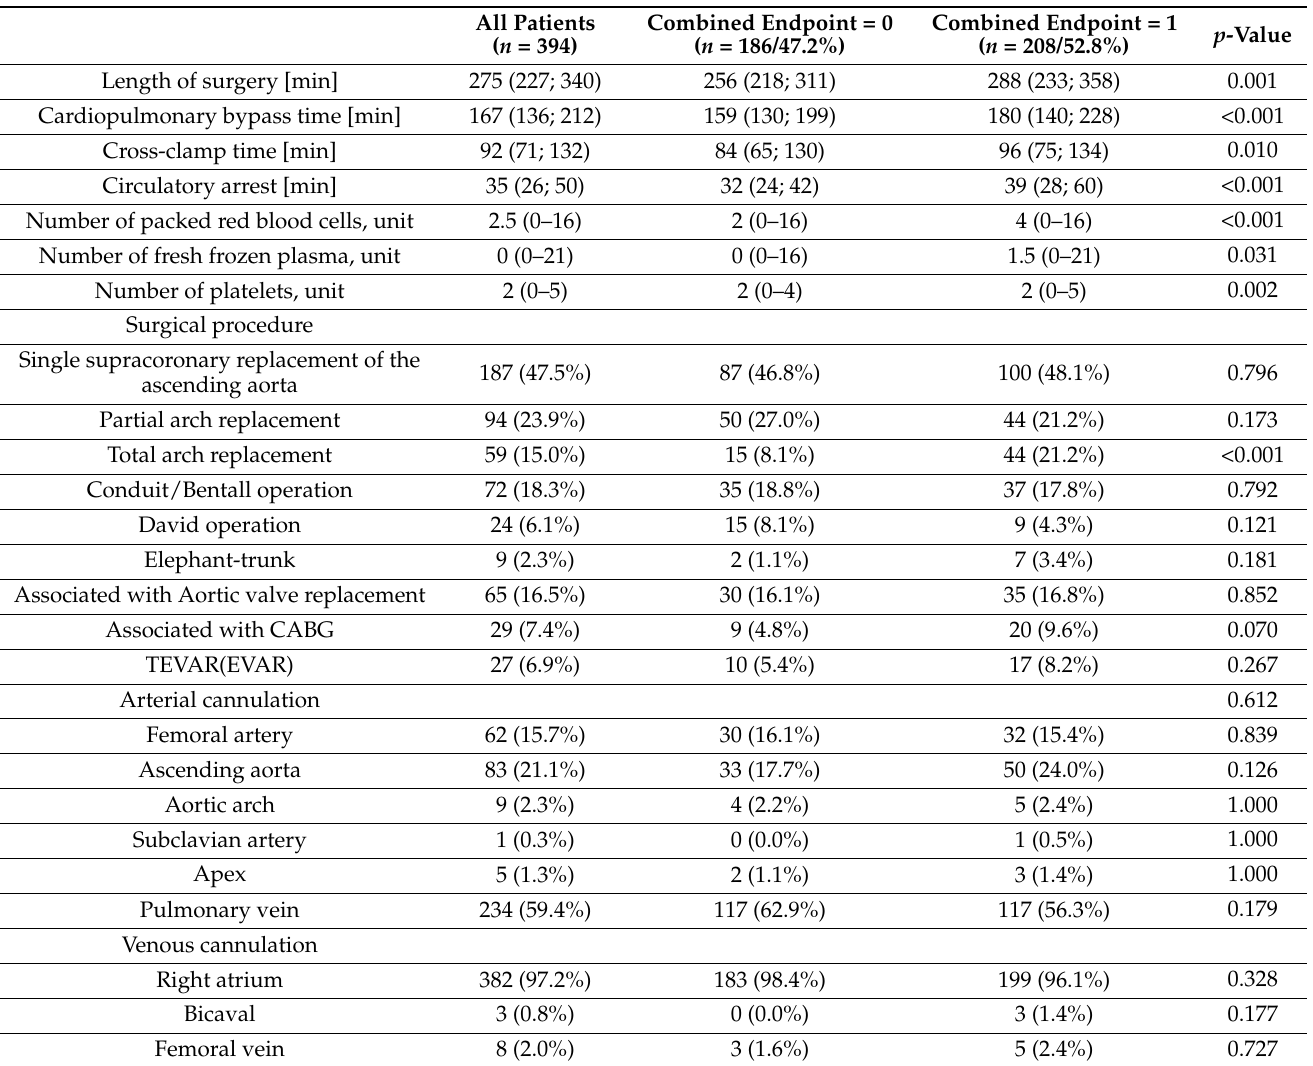
Table 2. Operative